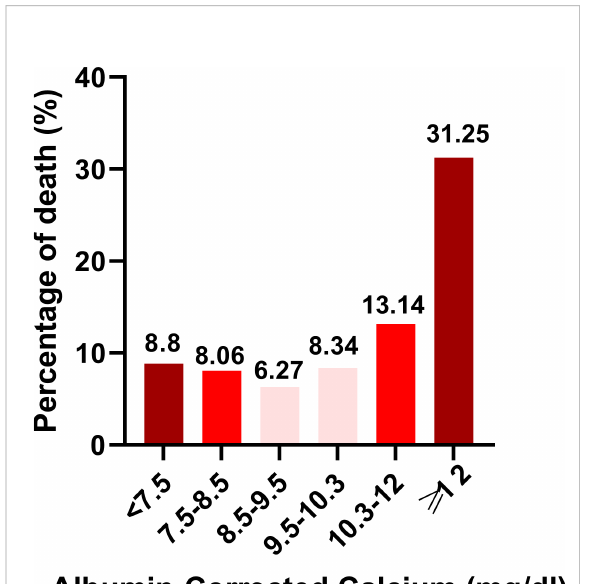
FIGURE 3 Histogram depicting percentage of death stratifed according to Albumin-Corrected Calcium (mgdl) categories.